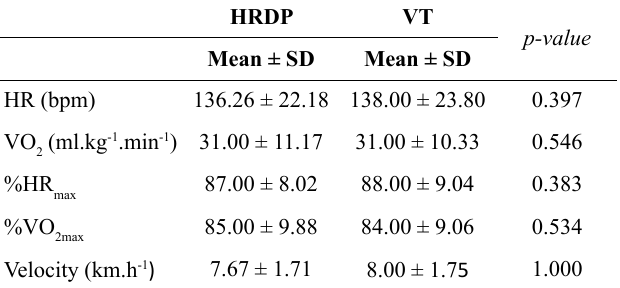
Table 2. Mean and standard deviation (SD) of heart rate (HR), oxy- gen uptake (VO ), percentage of maximal heart rate (%HR), percent- 2 age of maximal oxygen uptake (%VO ) and velocity during the 2max incremental treadmill test, based on the determination of anaerobic threshold by the heart rate deflection point (HRDP) and ventilatory (VT) methods. HRDP VT p-value Mean ± SD 136.26 ± 22.18 138.00 ±